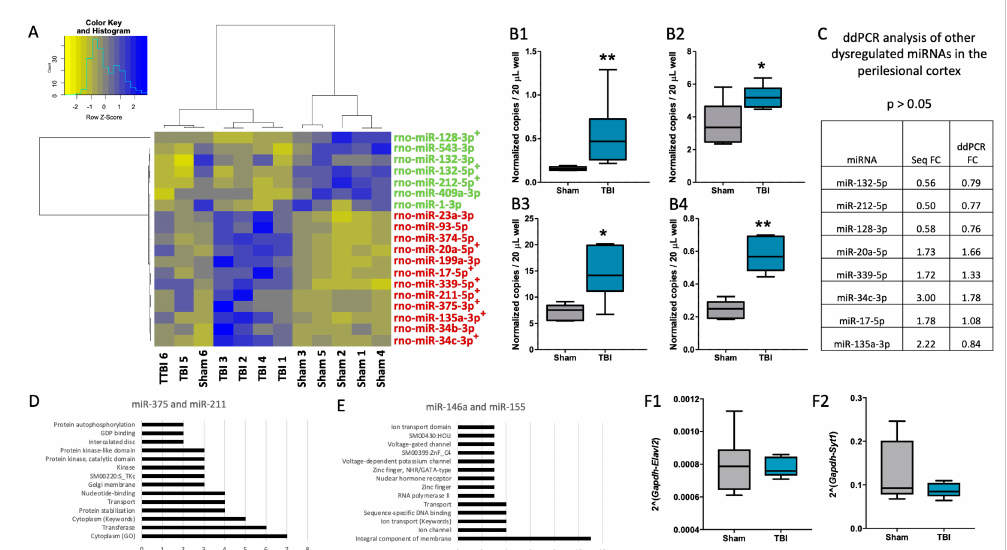
Figure 5. Deregulated microRNAs (miRNAs) after lateral fluid percussion injury. ( A ) Unsupervised hierarchical clustering partly separated sham-operated controls from post-TBI rats according to differentially expressed ( D , E ) miRNAs in the perilesional cortex. A total of 12 upregulated and 7 downregulated miRNAs were found (FDR <0.05). ( B1–B4 ) Droplet digital PCR (ddPCR) analysis validated miR-375 ( B1 , p < 0.01) and miR-211 ( B2 , p < 0.05) upregulation. In the ipsilateral thalamus, only 2 miRNAs were upregulated in small non-coding RNAseq analysis (sncRNAseq, FDR <0.05). Both of these were validated with ddPCR ( B3 , miR-146a, p < 0.05; B4 , miR-155, p < 0.01). ( C ) All